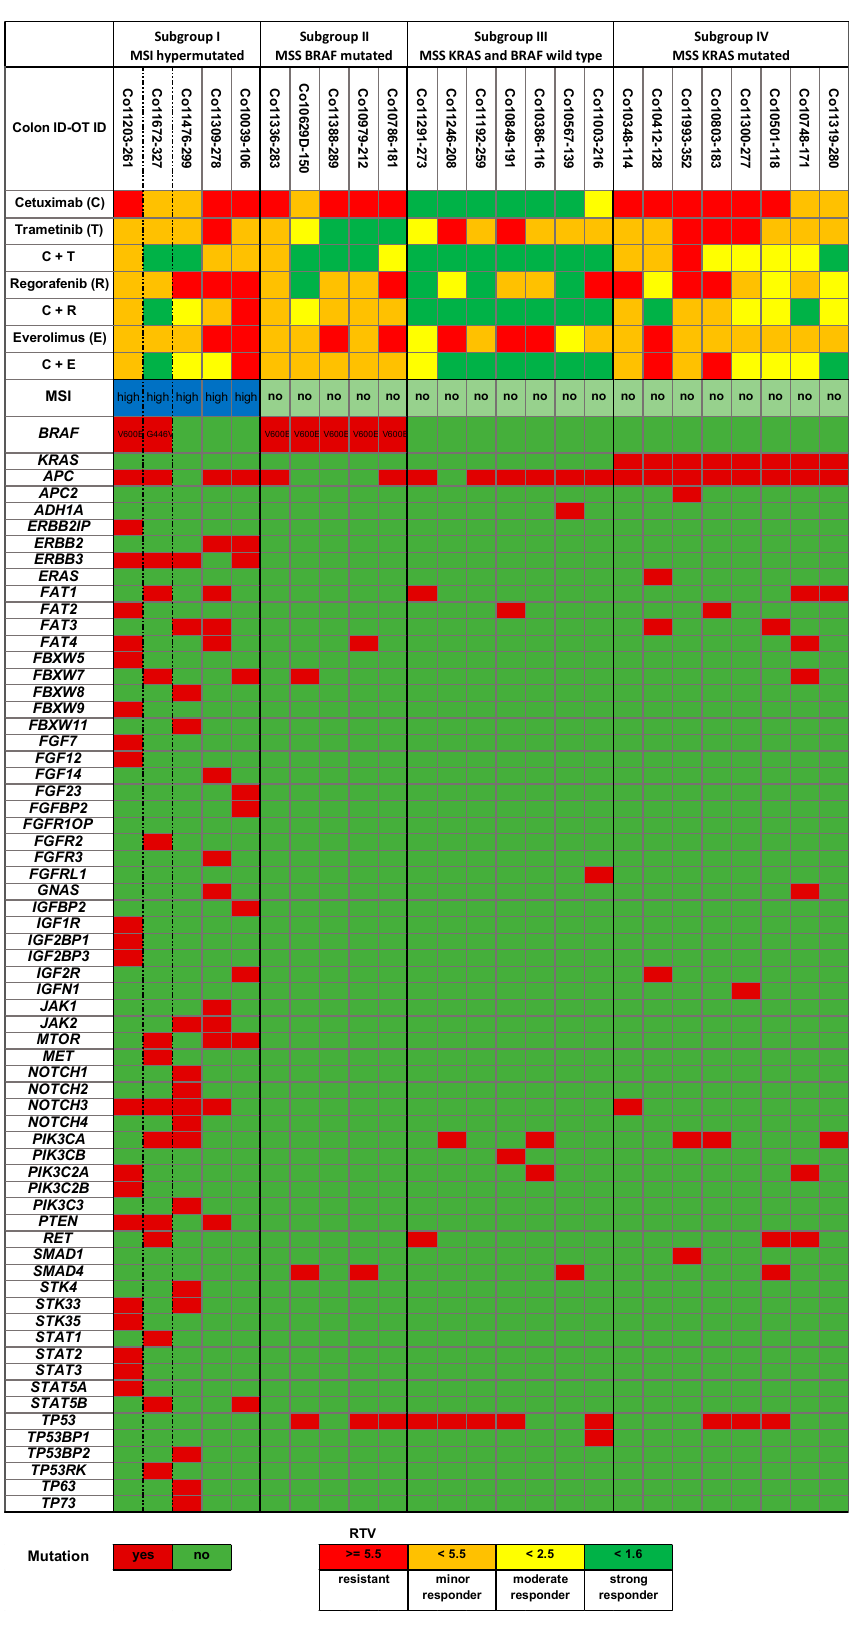
Figure 2. Response of 25 colon cancer PDX to cetuximab, regorafenib, trametinib, and everolimus in correlation with genetic mutation profile. Response data are provided as RTV values (RTV = quote of TV on the last day before study ended or start of quadruple treatment/TV on the first day of